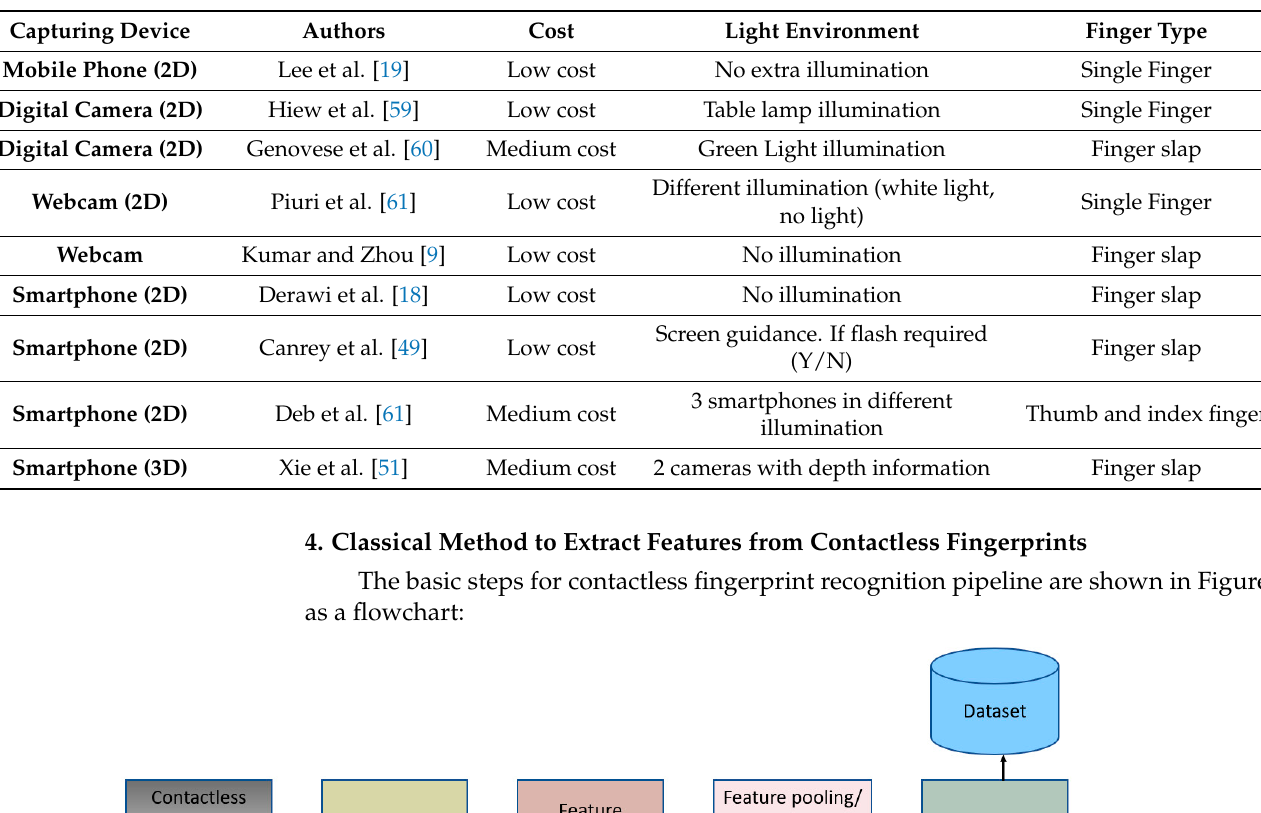
Table 2. Overview of contactless 2D and 3D capturing devices and their properties.